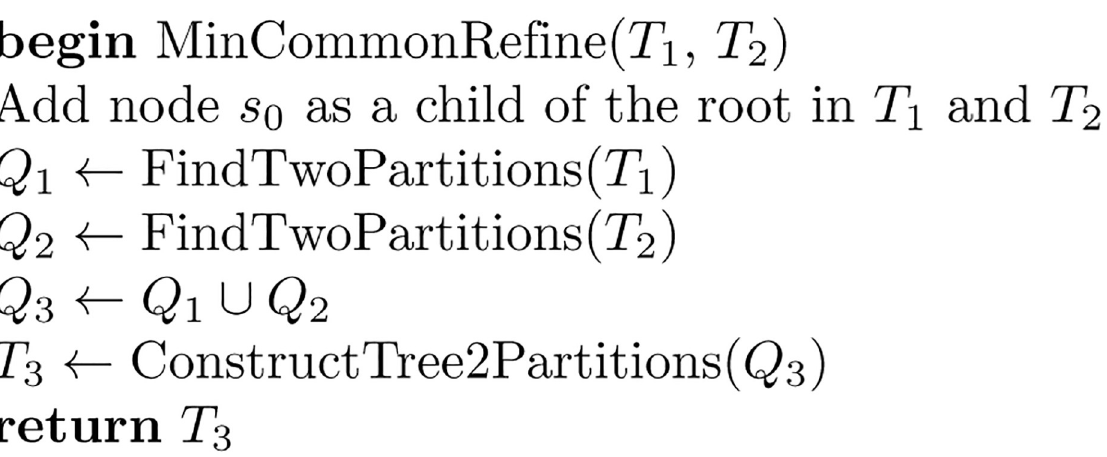
Fig 25. Algorithm to find the minimum common refinement of two trees.